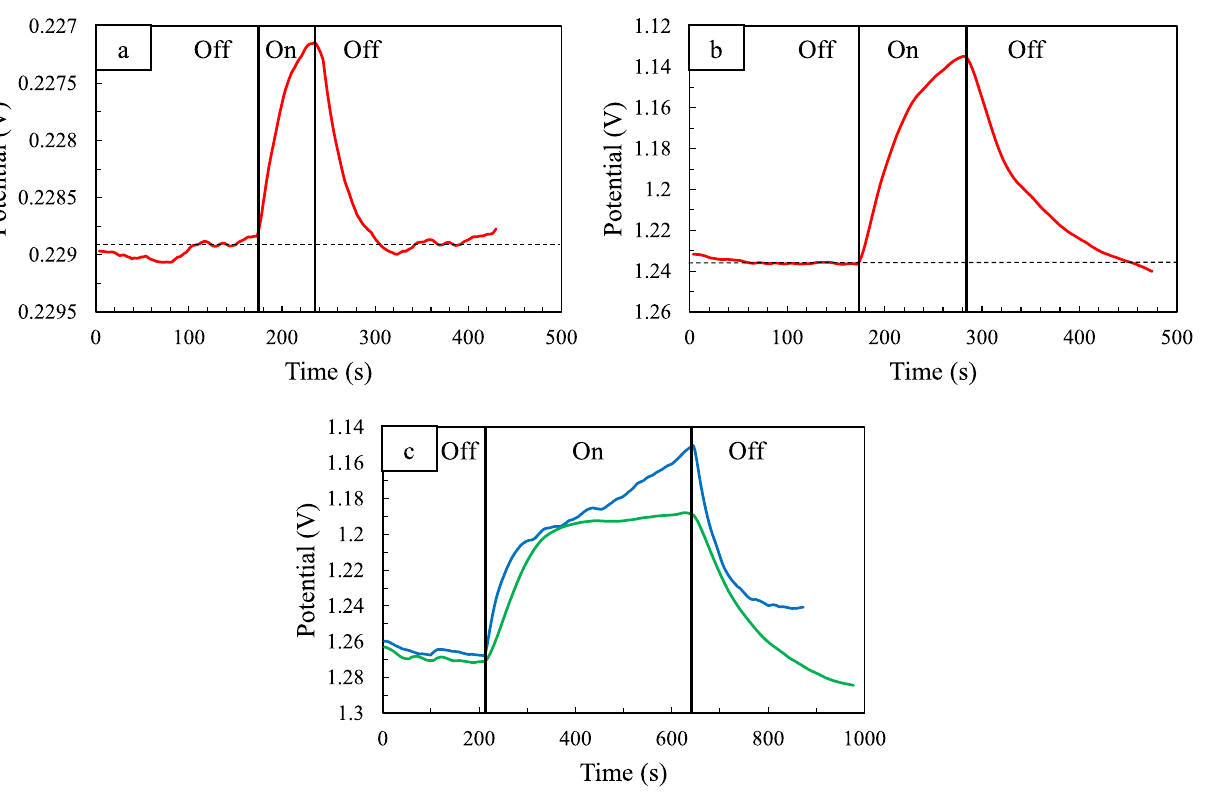
Figure 7. Plot of open circuit potential vs time for the same Ag nanoparticles photoelectrode without ( a ) and with ( b ) the modification of PVP during light irradiation ( λ inc = 465 nm). ( c ) Plot of open circuit potential vs time for Ag nanoparticles ( λ max = 430 nm) photoelectrode under irradiance at 465 nm (blue) and 528 nm (green) with equal light intensity. Horizontal dashed lines indicate open-circuit potential (OCP) baselines taken in the dark conditions. The terms on and off refer to the sample under irradiation (on) and the sample in the dark (off).